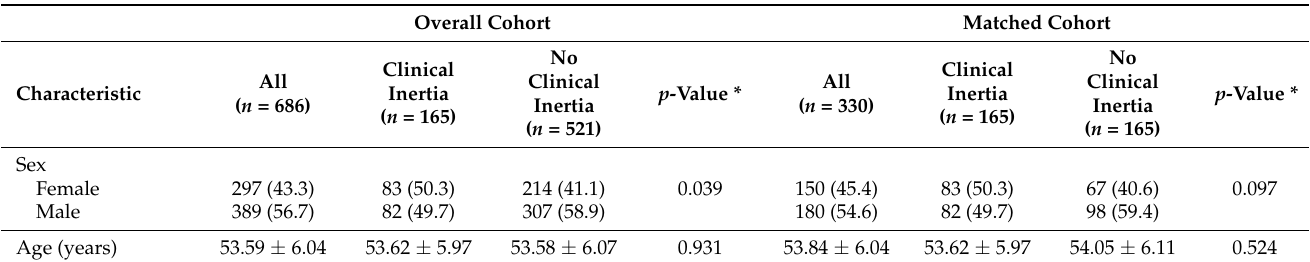
Figure 2. Patient enrollment flow diagram. * No blood sugar results at subsequent visit after the index date. “Admitted” was defined as patients who received inpatient treatment during the assessment of clinical inertia. Table 1. Baseline characteristics comparing between clinical inertia and no clinical inertia